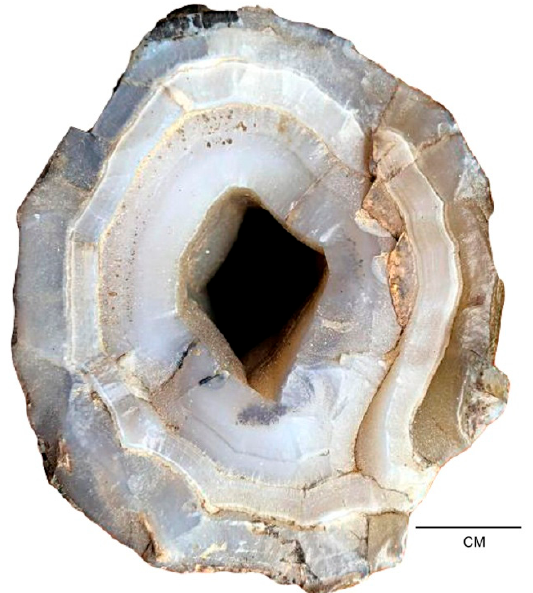
Figure 22. Blue Forest limb cast containing a large central void, a potential site for the future precipitation of calcite or quartz crystals.